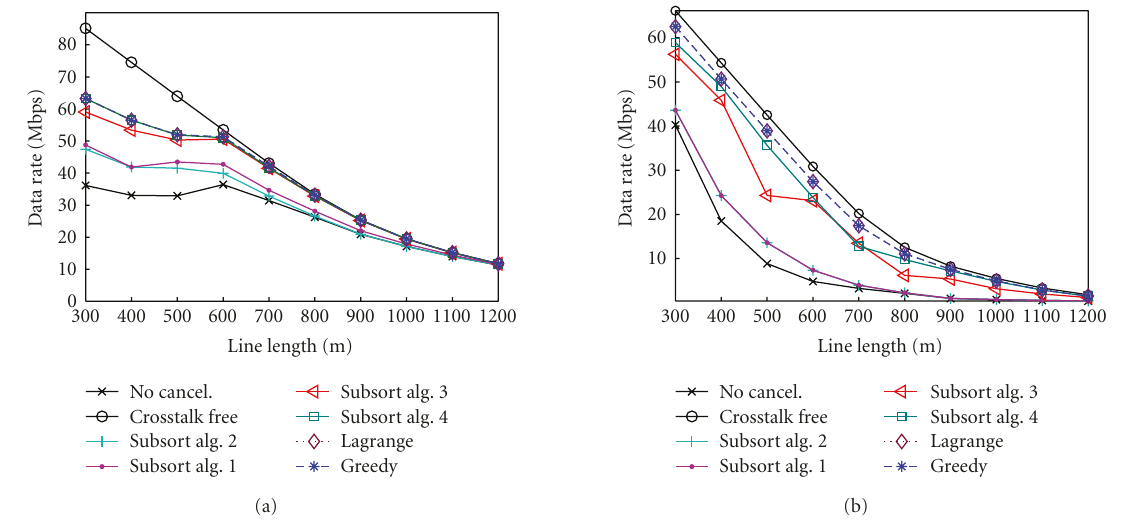
Figure 6: Data rates for proposed JTLS algorithms compared to the optimal solution for distributed Scenario 1: (a) downstream ( p = 4) and (b) upstream ( p =